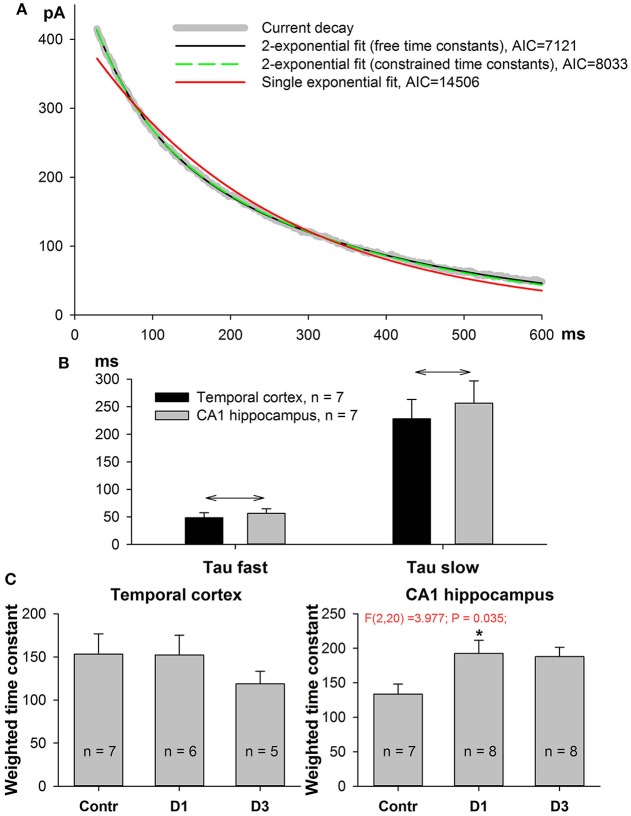
Kinetics of NMDAR-mediated evoked EPSC slow down in PILO-rats. (A) A representative 90–10% decay phase of NMDAR-mediated evoked EPSC fitted with various functions. The black line is a double exponential fit with Equation (7) (time constant were allowed to vary during approximation, resulting in τfast = 56 ms, τslow = 345 ms). Green dashed line represent a double exponential fit with Equation (9) with the fixed time constants, τfast = 60 ms, τslow = 300 ms. An Equation (9) with constrained time constants produces an approximation which is indistinguishable from the one produced by an Equation (7) and produces a much better fit (smaller AIC) than monoexponential function [Equation (8), red line]. (B) In both brain regions the average fast and slow time constants obtained by fitting with Equation (7) are significantly different. Asterisks (*) indicate significant difference (p < 0.05) between the fast and slow time constants (paired t-test). (C) In both brain regions, the partial block of evoked EPSC by ifenprodil does not significantly affect the time constants (paired t-test).